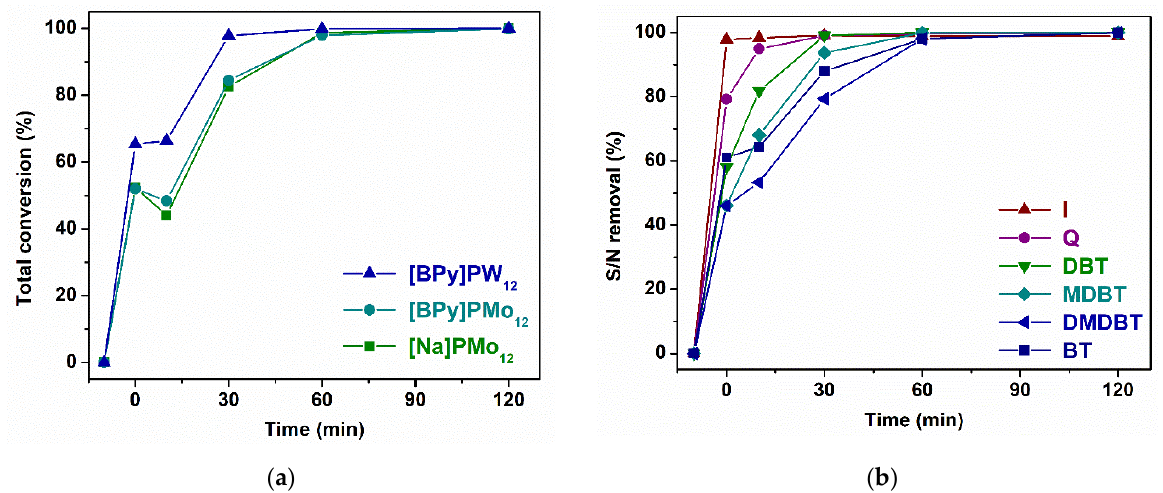
Figure 2. ( a ) Combined denitrogenation and desulfuration profiles catalyzed by the various POMs, using a biphasic S/N Model Diesel/[BMIM]PF 6 system, H 2 O 2 as oxidant, at 70 °C; ( b ) denitrogenation and desulfurization profile of each SCs and NCs present in the Model Diesel, using [Na]PMo 12 catalyst.